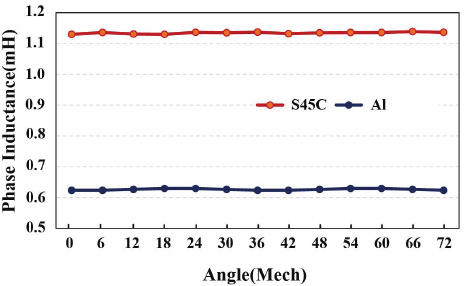
Figure 5. Calculated phase inductance at different rotor position.